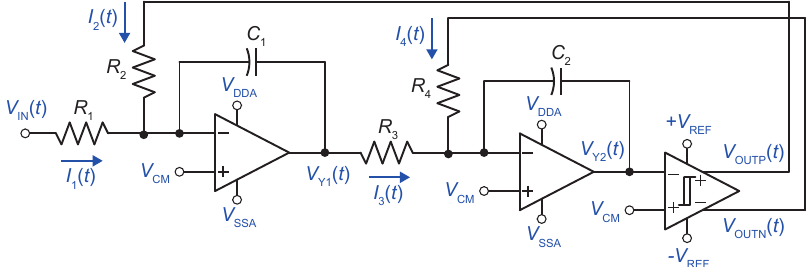
Figure 2. Simplified schematic of the second-order ADSM with the CIFB